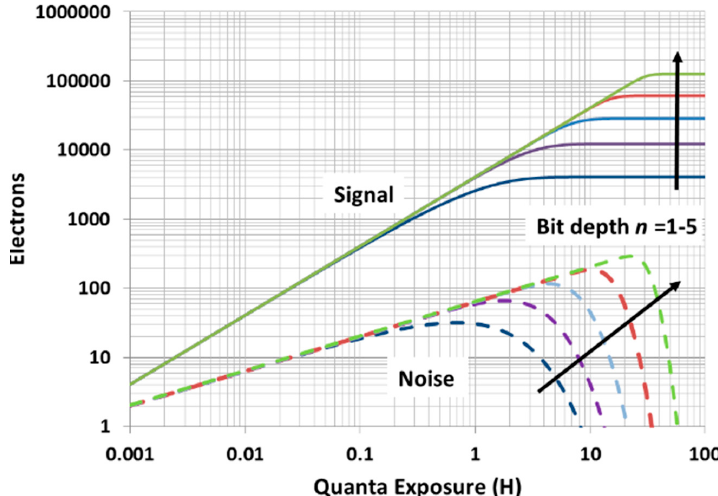
Figure 4. Log signal and noise as a function of log exposure for multi-bit QIS jots with varying bit depth. The signal is the expected sum over 4096 jots (e.g., 16 × 16 × 16). Saturation signal is 4096 (2 n − 1) (From [14]).